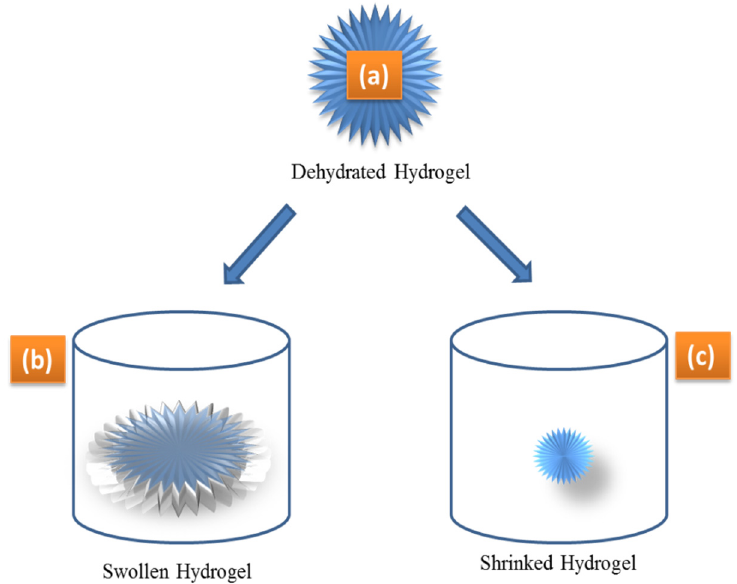
Figure 3. Dehydrated ( a ), swollen ( b ), and shrunken ( c ) hydrogels as a result of small changes in external stimuli, such as pH, temperature, and analyte concentration that influence the hydrogel hydrophilicity.